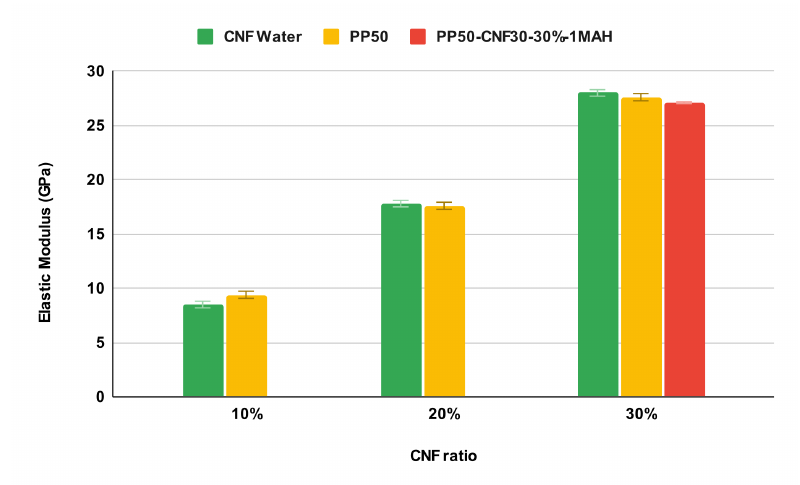
Figure 7. The uniaxial Young’s modulus is determined parallel to cellulose nanofibrils that correspond to 10%, 20%, or 30% of the simulation cell by molecular weight. CNF30 Water is a system where CNF with 30 monomers in a chain is solvated in water. PP50 is a system where CNF30 is embedded in a PP matrix (PP chains with 50 monomers). In PP50-CNF30-30%-1MAH, CNF30 and PP50 are further coupled with a maleic anhydride coupling agent in such a way that the ratio of CNF is 30% by mass percent.